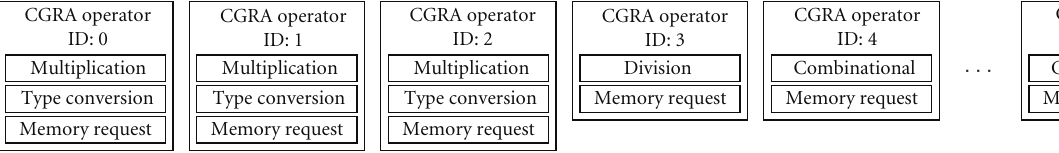
Figure 10: Specialization of an array with 3 multiplication operators and 1 division operator.